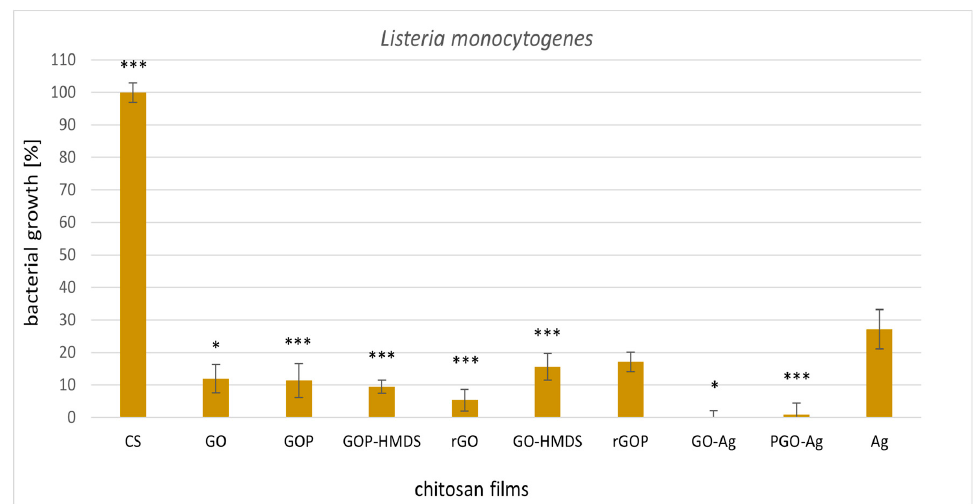
Figure 3. Reduction of Listeria monocytogenes ATCC 15313 with treatments with metal-oxide chitosan films after 24 h incubation. The value from control group (CS) was set as 100%. Statistical significance is marked in relation to the chitosan nanocomposite (CS) ( n = 6, * p < 0.05, *** p < 0.001).